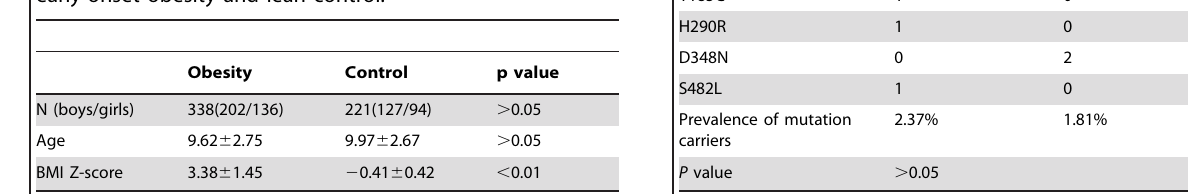
Table 1. The anthropological characteristics of children with early-onset obesity and lean control.